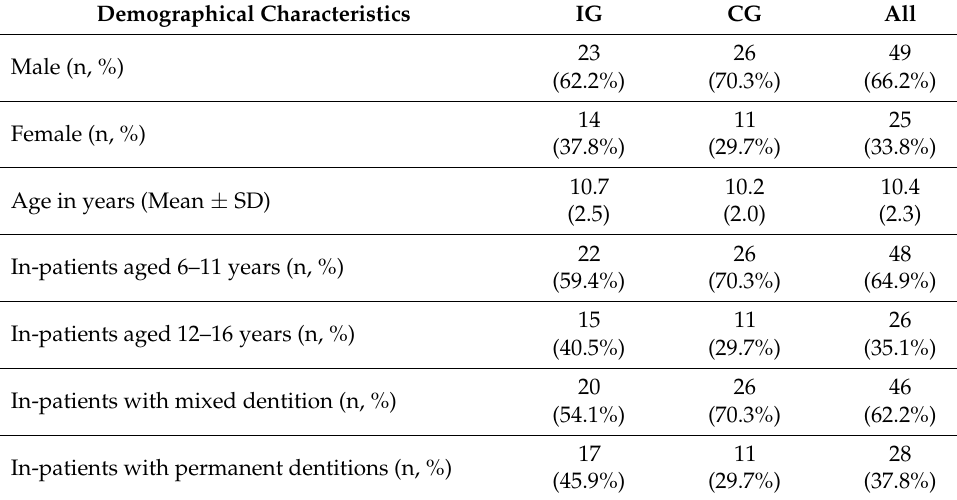
Table 1. Demographic characteristics of the study population, intervention group (IG), and control group (CG).